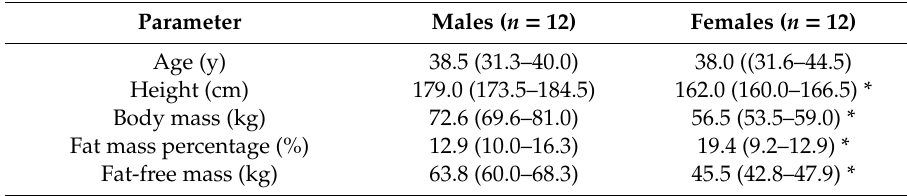
Table 1. Basic characteristics and dietary intake of subjects, median (Interquartile